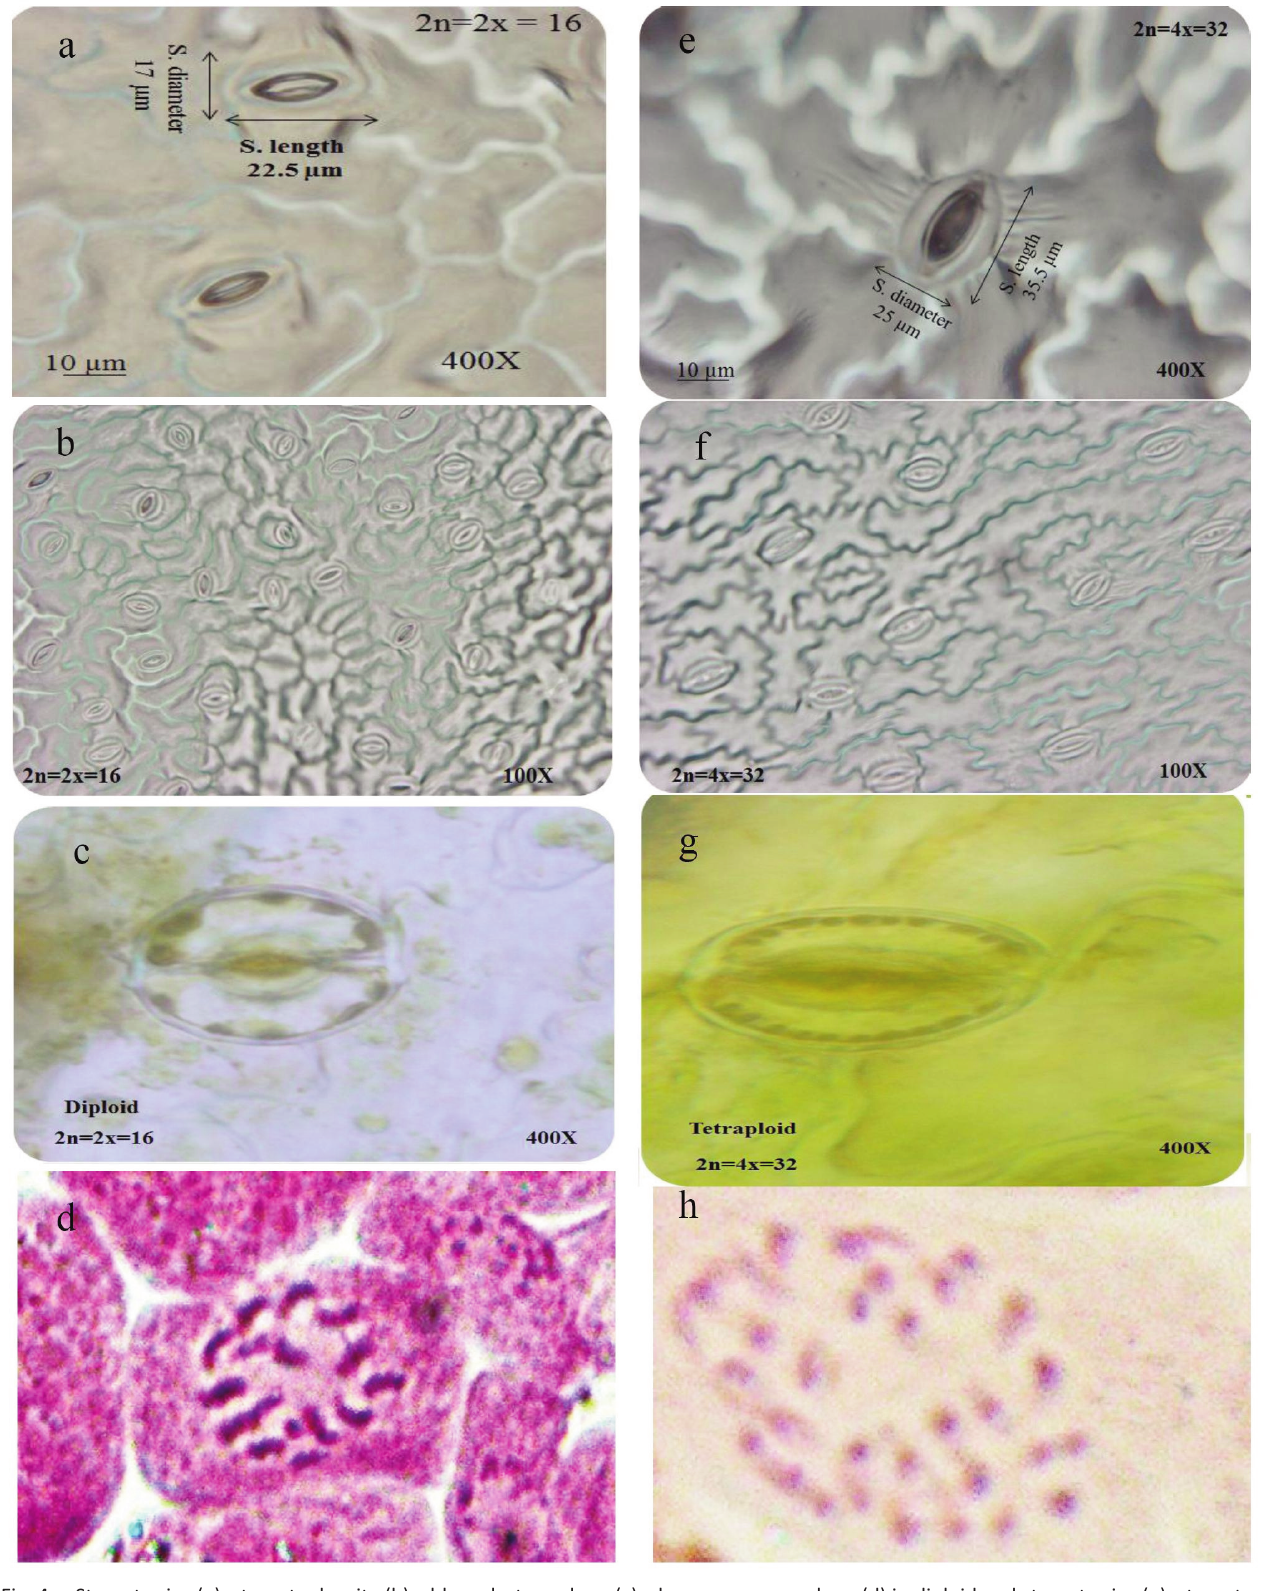
Fig. 4 - Stomata size (a), stomata density (b), chloroplast numbers (c), chromosome numbers (d) in diploid and stomata size (e), stomata density (f), chloroplast numbers (g) and chromosome numbers in tetraploid (h) of C. roseus ‘Alba’